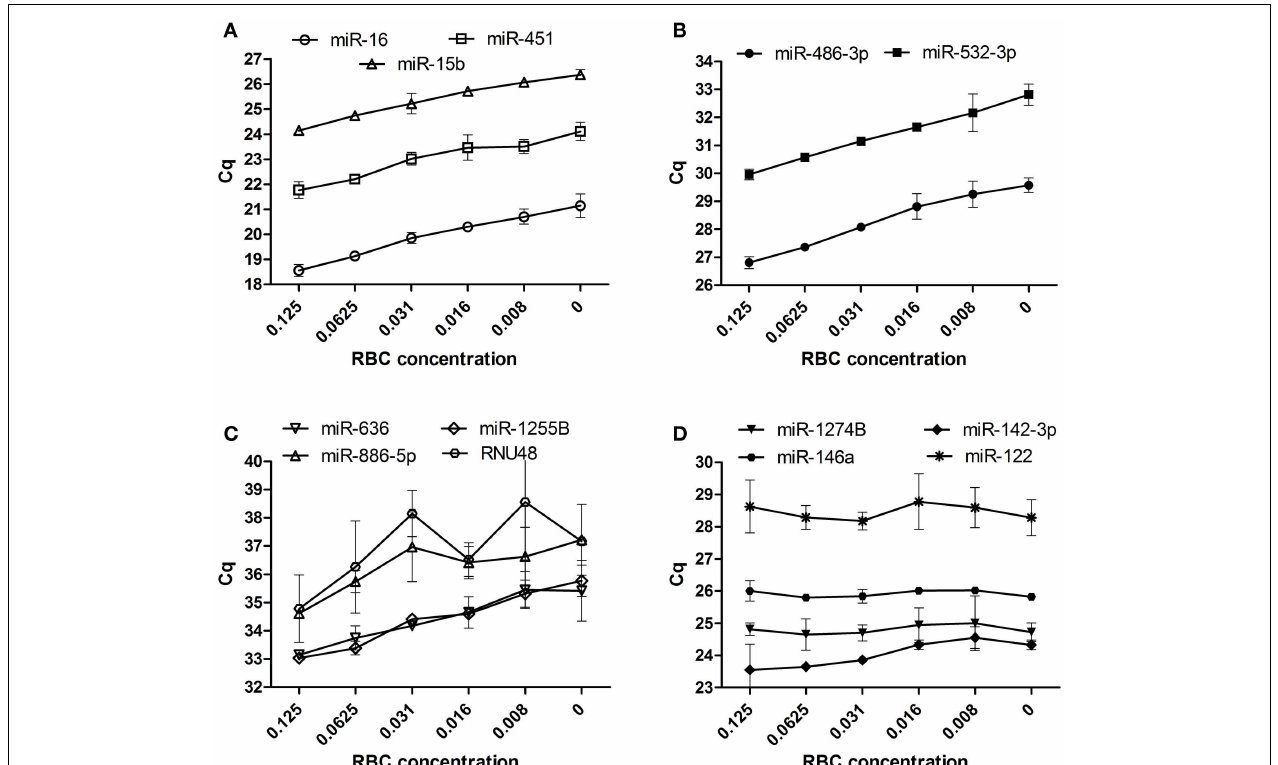
specific microRNAs (D) unaffected microRNAs. Data are presented as raw Cq value ± SD obtained from measurements in RNA isolated from two independent dilution series.